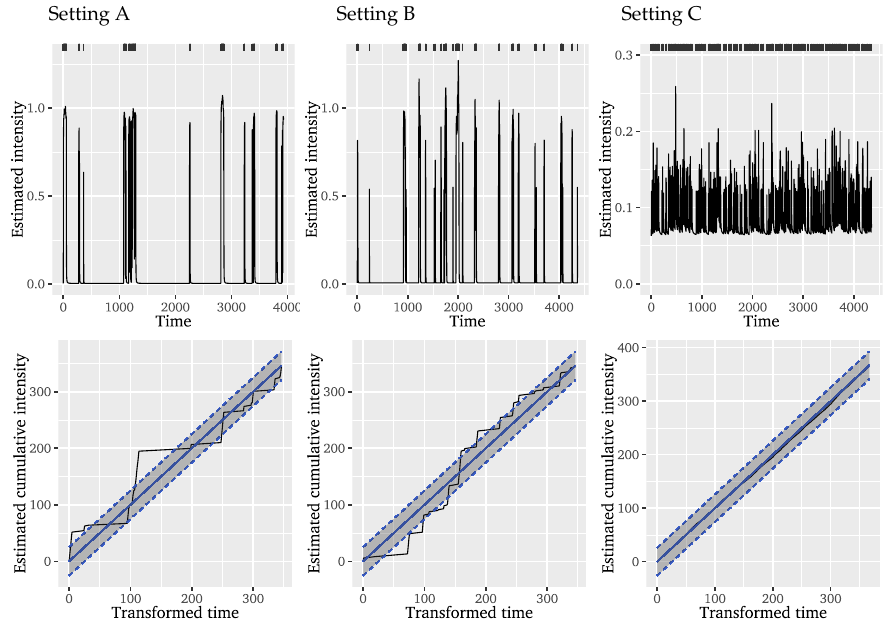
Figure 13. Estimated conditional intensity and cumulative intensity of the Hawkes-POT model (with ETAS decay) and for the simulated settings A, B and C. Ticks on the upper axis represent events. 95% confidence bands are based on the Kolmogorov–Smirnov statistic